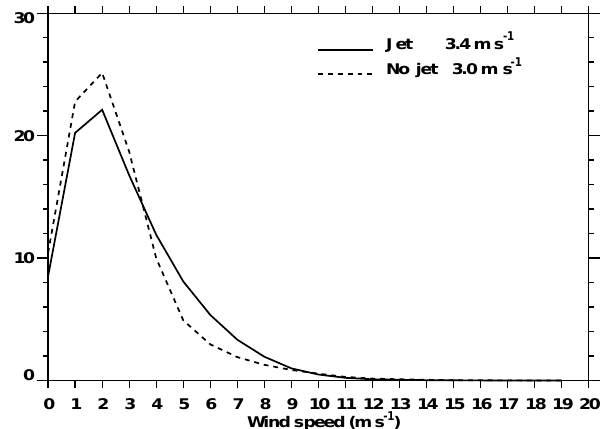
Figure 7. Frequency distribution of 10m wind speed at 06:00UTC (i.e., roughly at 11:30LT) over the Tarim